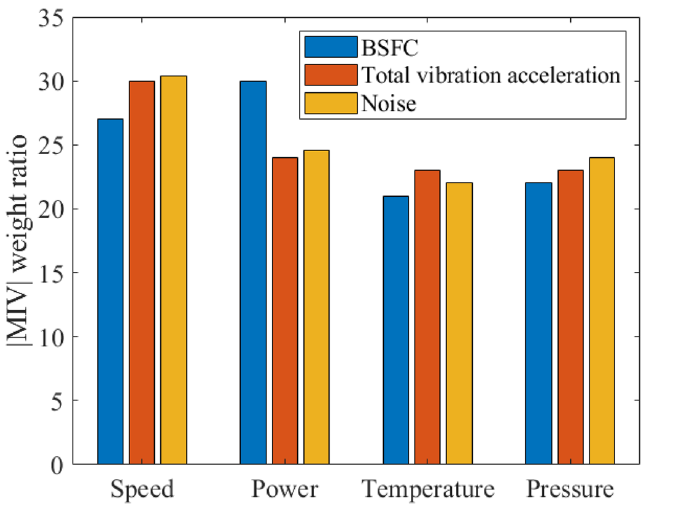
Figure 16. MIV weighting ratio of the input